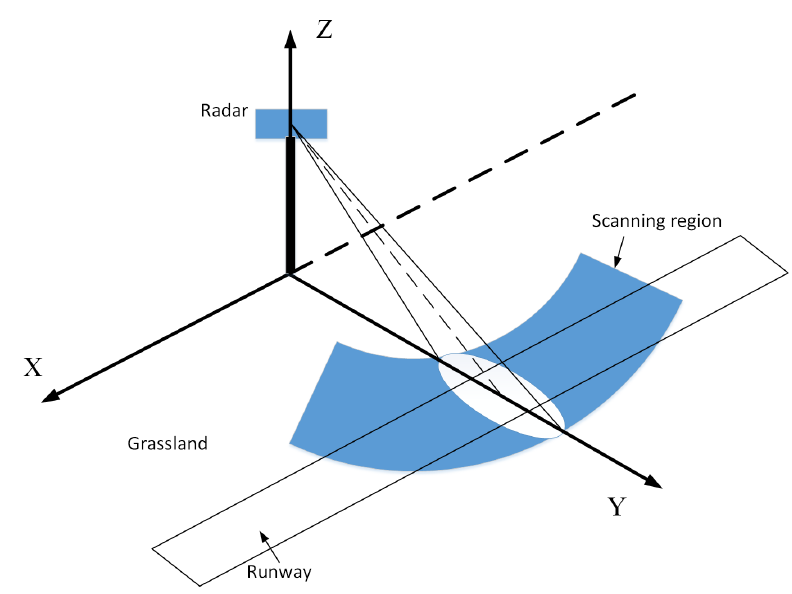
Figure 1. Geometry of FOD millimeter-wave radar